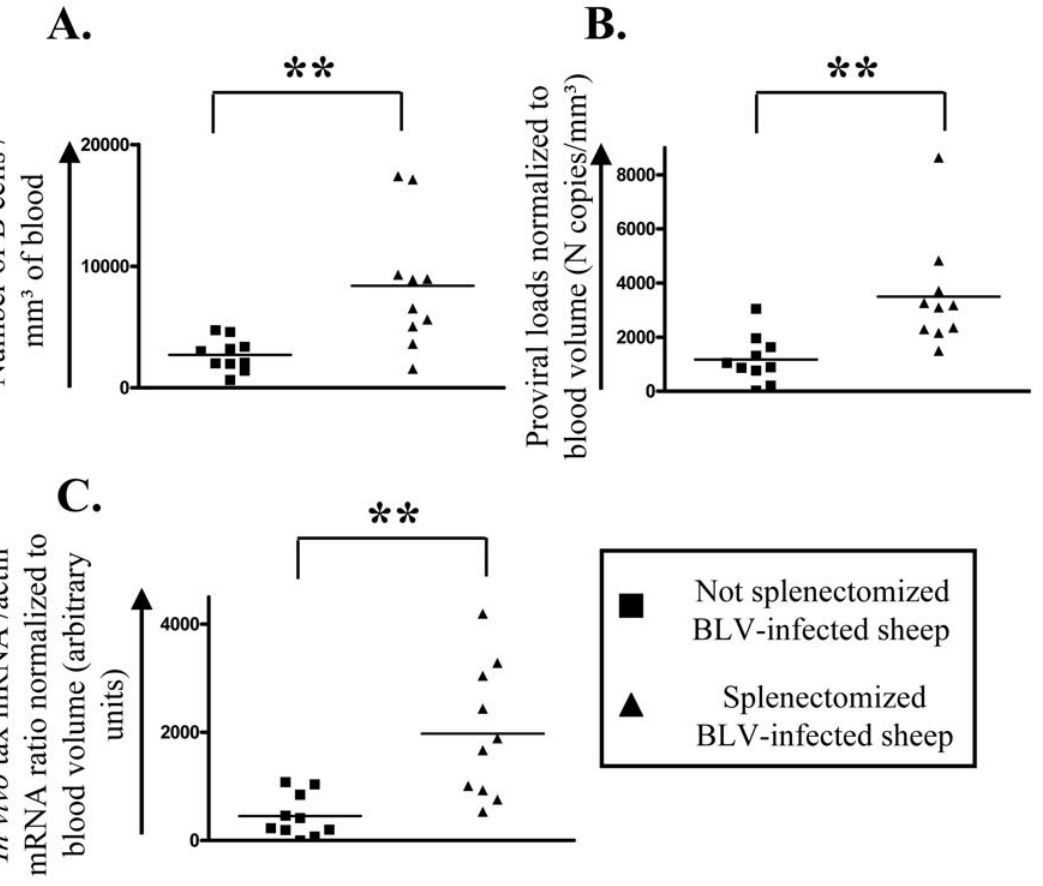
Figure 3. Influence of splenectomy on B cells counts, proviral loads and in vivo viral expression. 20 sheep were infected with BLV. A few months after seroconversion (average delay: 4.6 months), 10 of them were splenectomized. Blood was collected at regular intervals of time and different parameters were measured. Each value represents the average of 3 representative data in not splenectomized ( & ) and splenectomized ( m ) animals. (A) Numbers of B lymphocytes/mm 3 of blood. (B) Proviral loads (in numbers of viral copies/mm 3 of blood were determined by real time PCR and normalized to the blood volume. (C) Proportions between tax and actin transcripts (in arbitrary units) were measured by real time RT-PCR and normalized to the blood